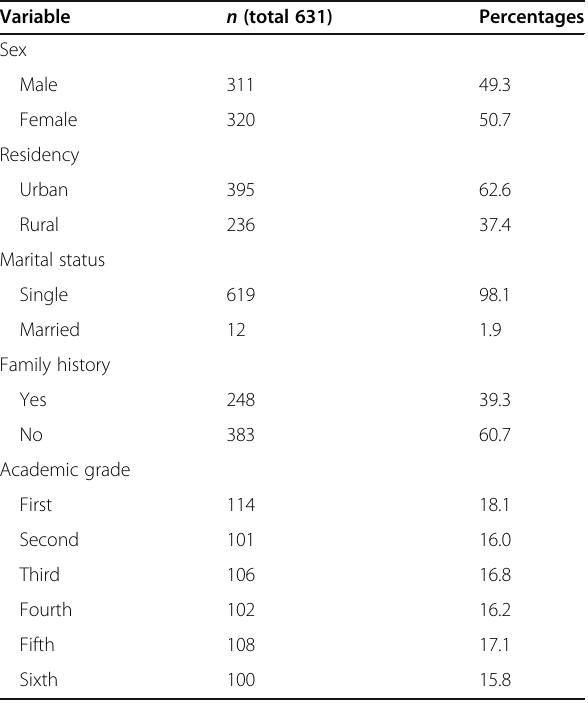
Table 1 Sociodemographic characteristics of medical